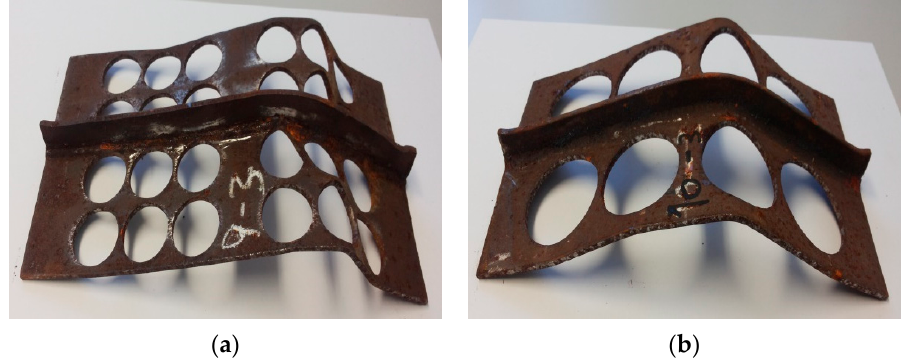
Figure 11. Post-collapse deformed shape for n = 24, DoO = 42.90%, SP-NS9-3 ( a ) and SP-NS10-3, n = 8 ( b ).